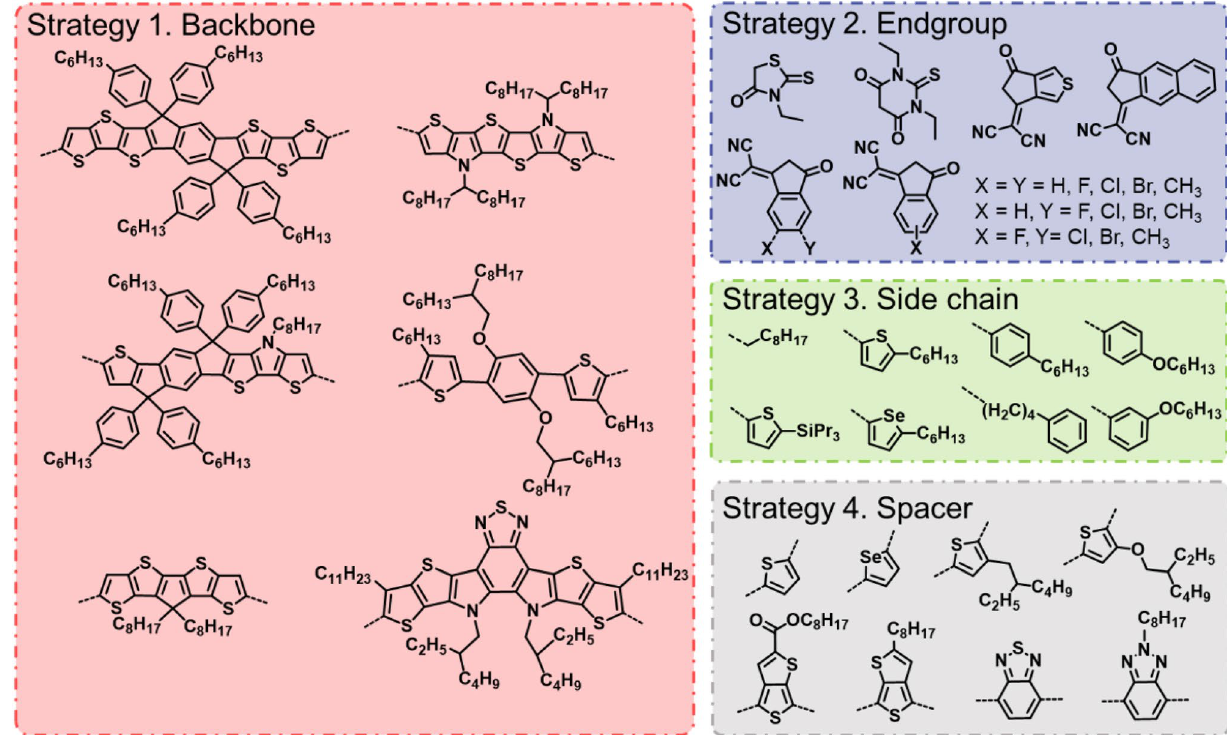
Fig. 4 Structural modification strategies for A-D-A-type